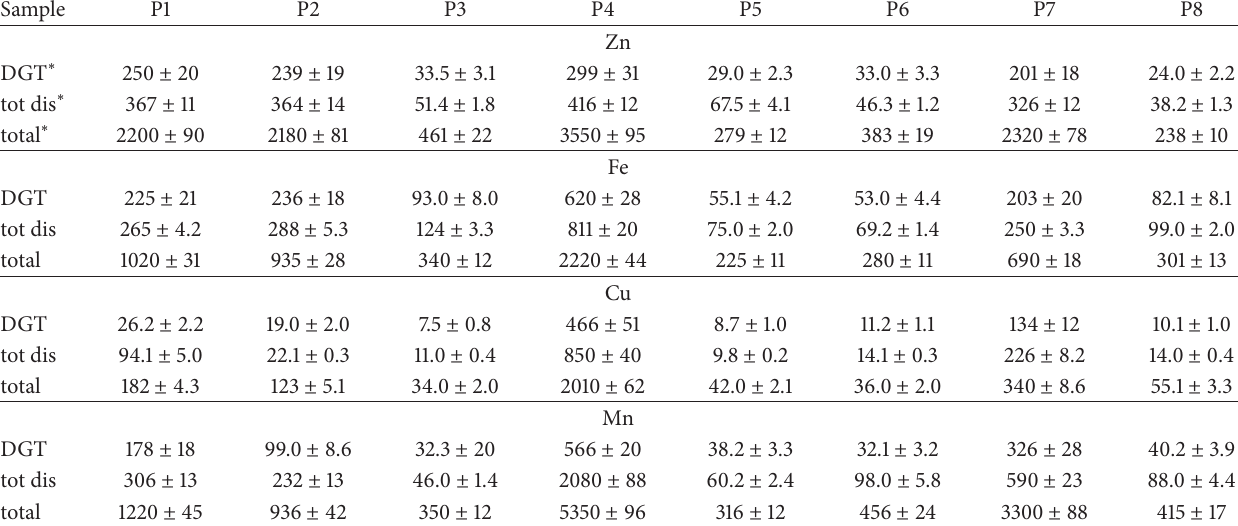
Table 2: Concentrations of DGT-labile and total dissolved and total metal concentrations ( 𝜇 gL − 1 , mean ± standard deviation, 𝑛 = 3 parallel